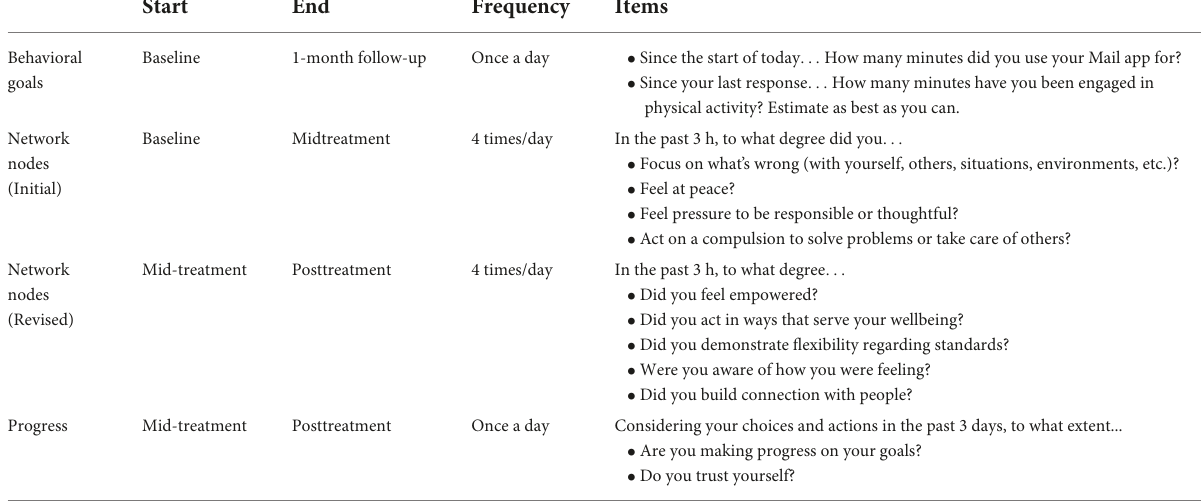
TABLE 1 Personalized ecological momentary assessment items over the course of